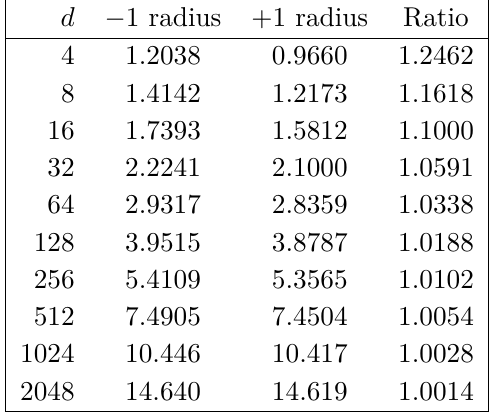
Table 2 . The ratio of the − 1 eigenfunction uncertainty principle radius to the +1